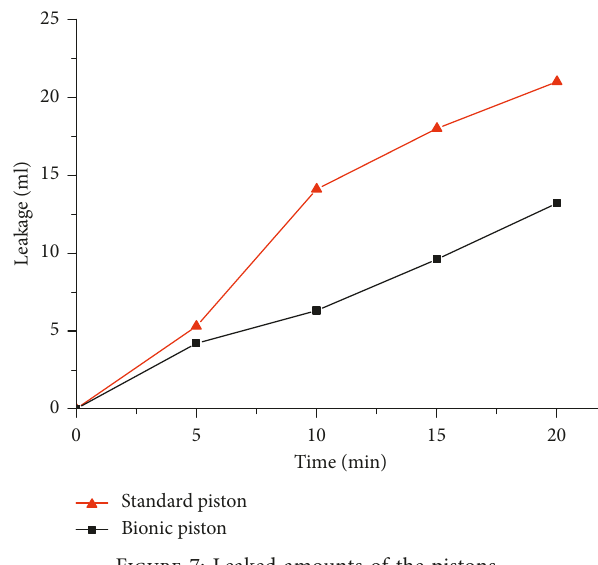
Figure 7: Leaked amounts of the